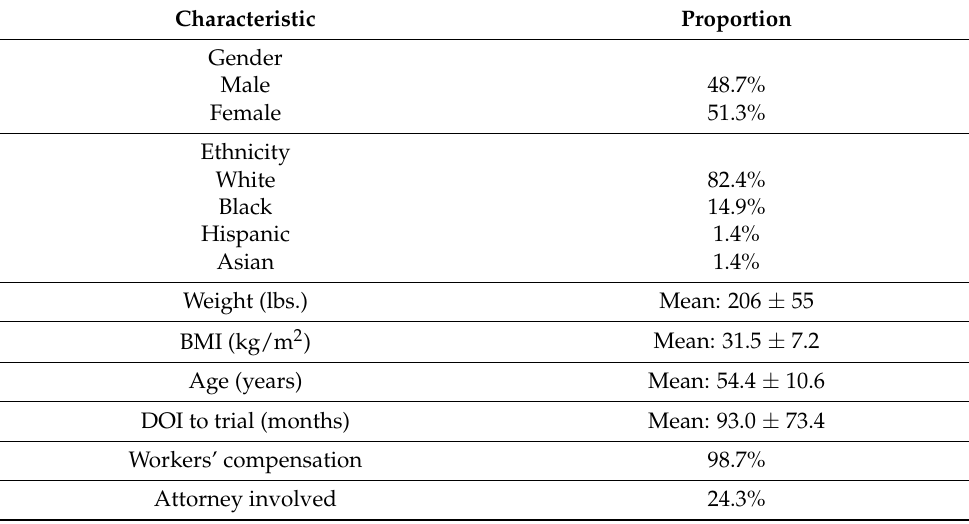
Table 1. Demographics of HWDS intervention